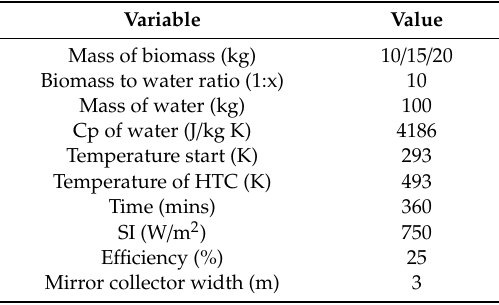
Table 9. Constant variables for biomass comparison.